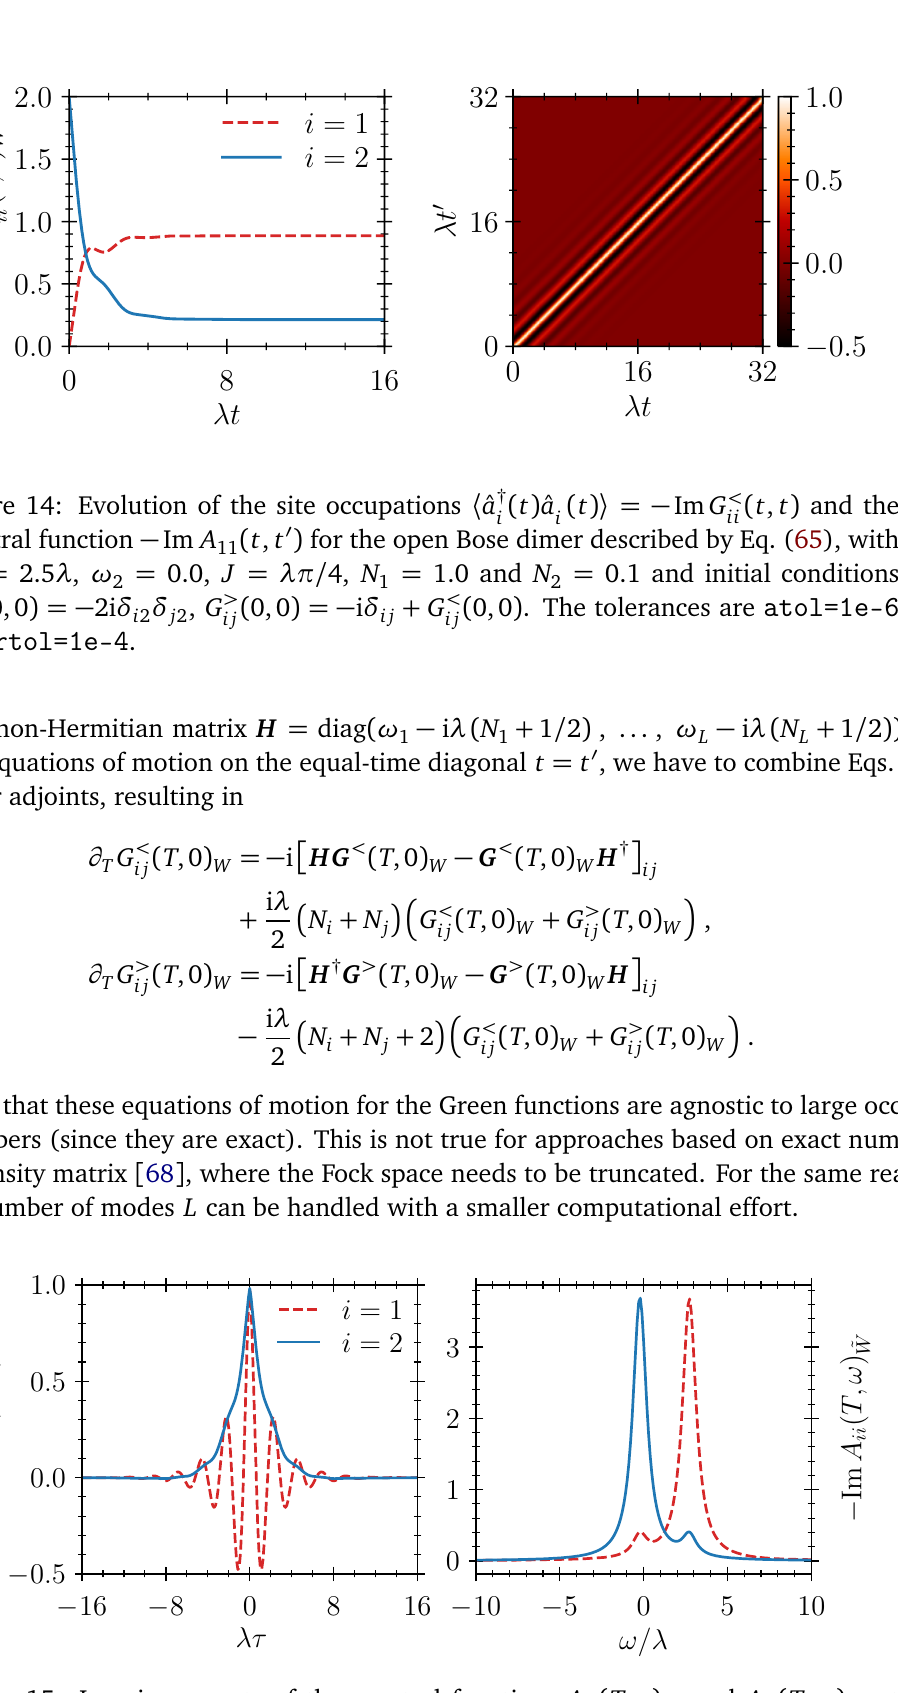
Figure 15: Imaginary parts of the spectral functions A centre-of-mass time λ T = 16. The system is the open dimer of Fig.